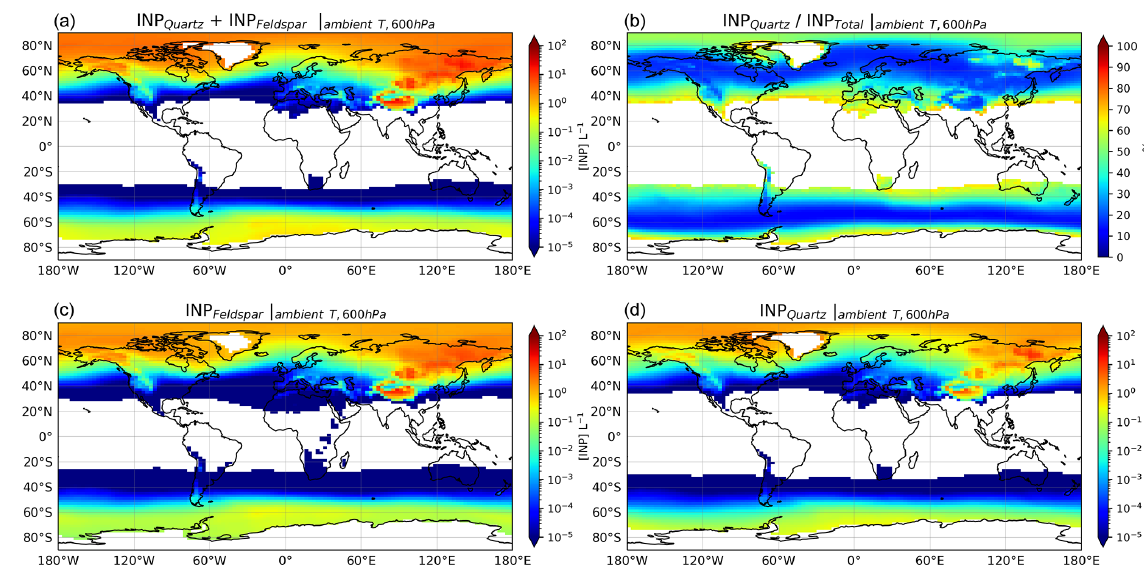
Figure 7. Annual-mean distributions of ice-nucleating particles number concentrations [INP] ambient , calculated by TM4-ECPL at ambient (model’s) temperature and 600hPa based on the presence both of K-feldspar and quartz (a) . Ratio of INPs from quartz over total INPs from K-feldspar and quartz at the same conditions (b) . Panels (c) – (d) show the corresponding INP concentrations derived individually from each mineral: K-feldspar (c) and quartz (d) .